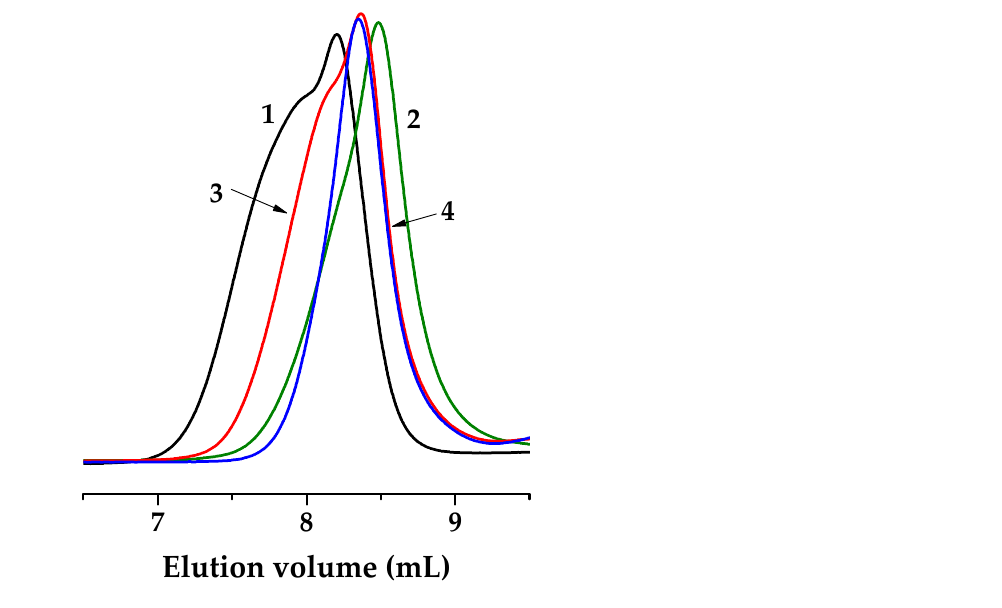
Figure 1. SEC traces of poly( ε -caprolactone): (1) run 6, Table 1; (2) run 7, Table 2; (3) run 8, Table 2 and (4) run 12, Table 2.